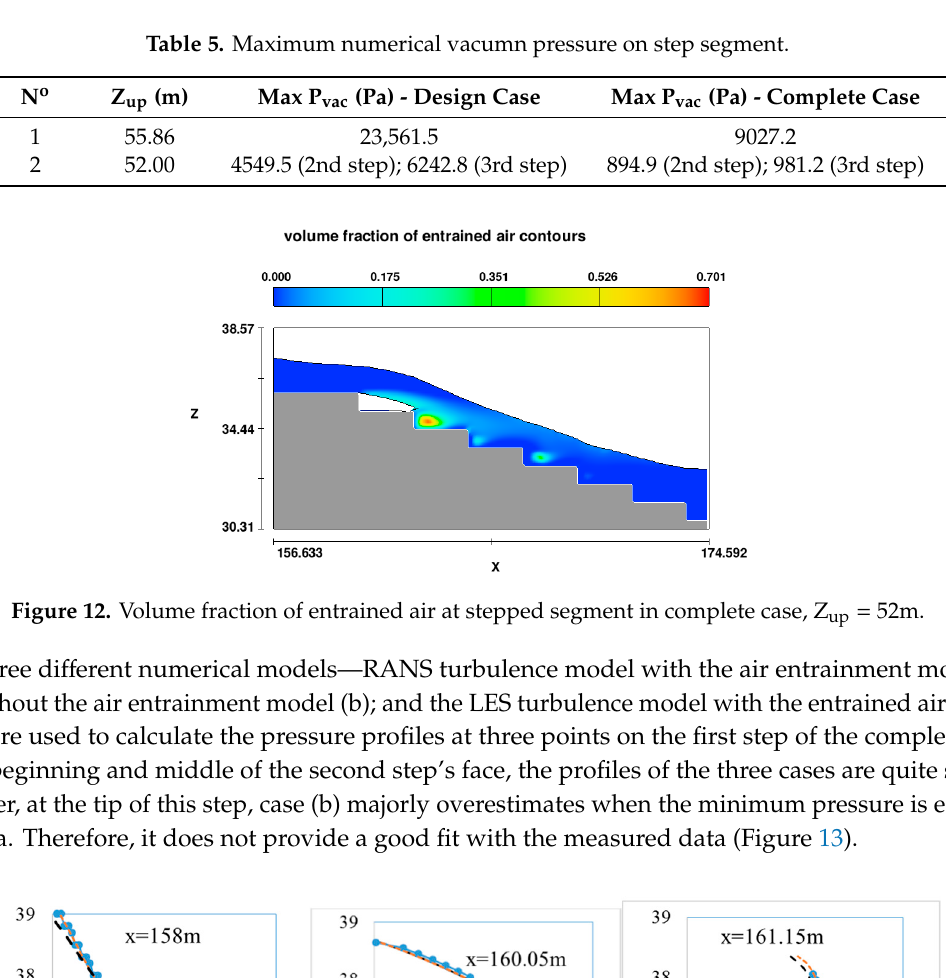
Figure 11. Water elevation and velocity in the complete case and Z up = 55.86 m.